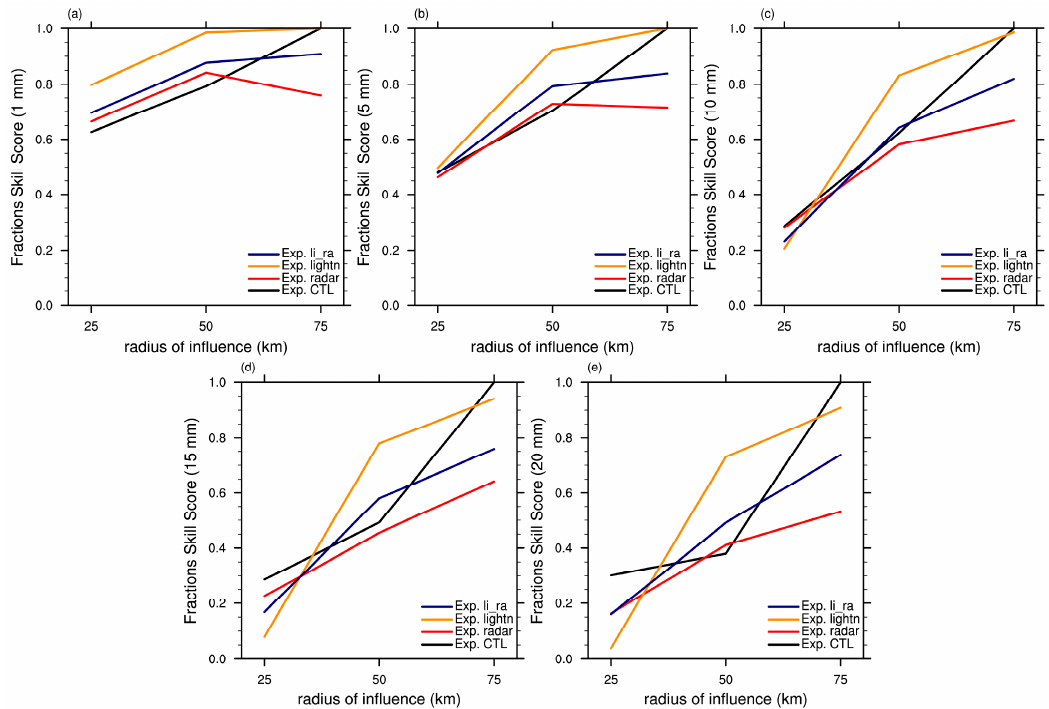
Figure 10. Fractions Skill Score (FSS) for different thresholds of 6 h accumulated precipitation (( a ) 1 mm; ( b ) 5 mm; ( c ) 10 mm; ( d ) 15 mm; and ( e ) 20 mm) in Exp. CTL, Exp. radar, Exp. lightn and Exp. li_ra. The perfect value of FSS is 1.00.